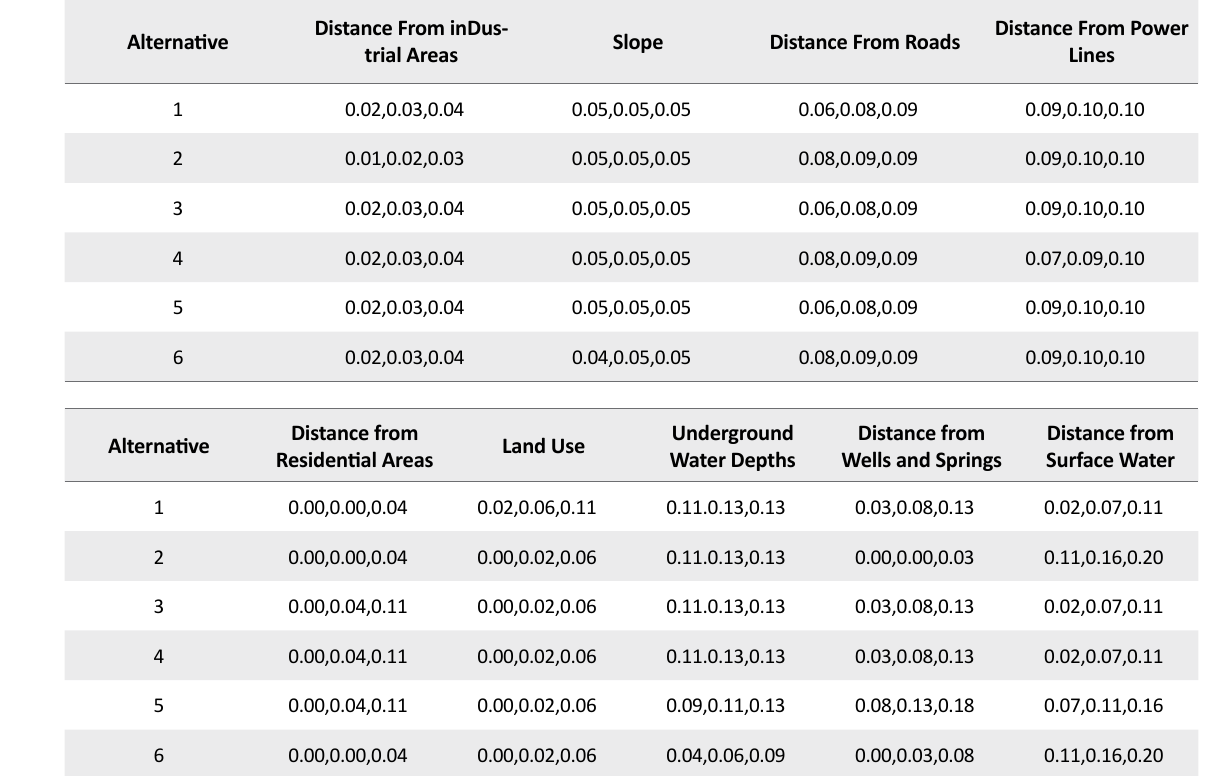
Slope Distance From Roads